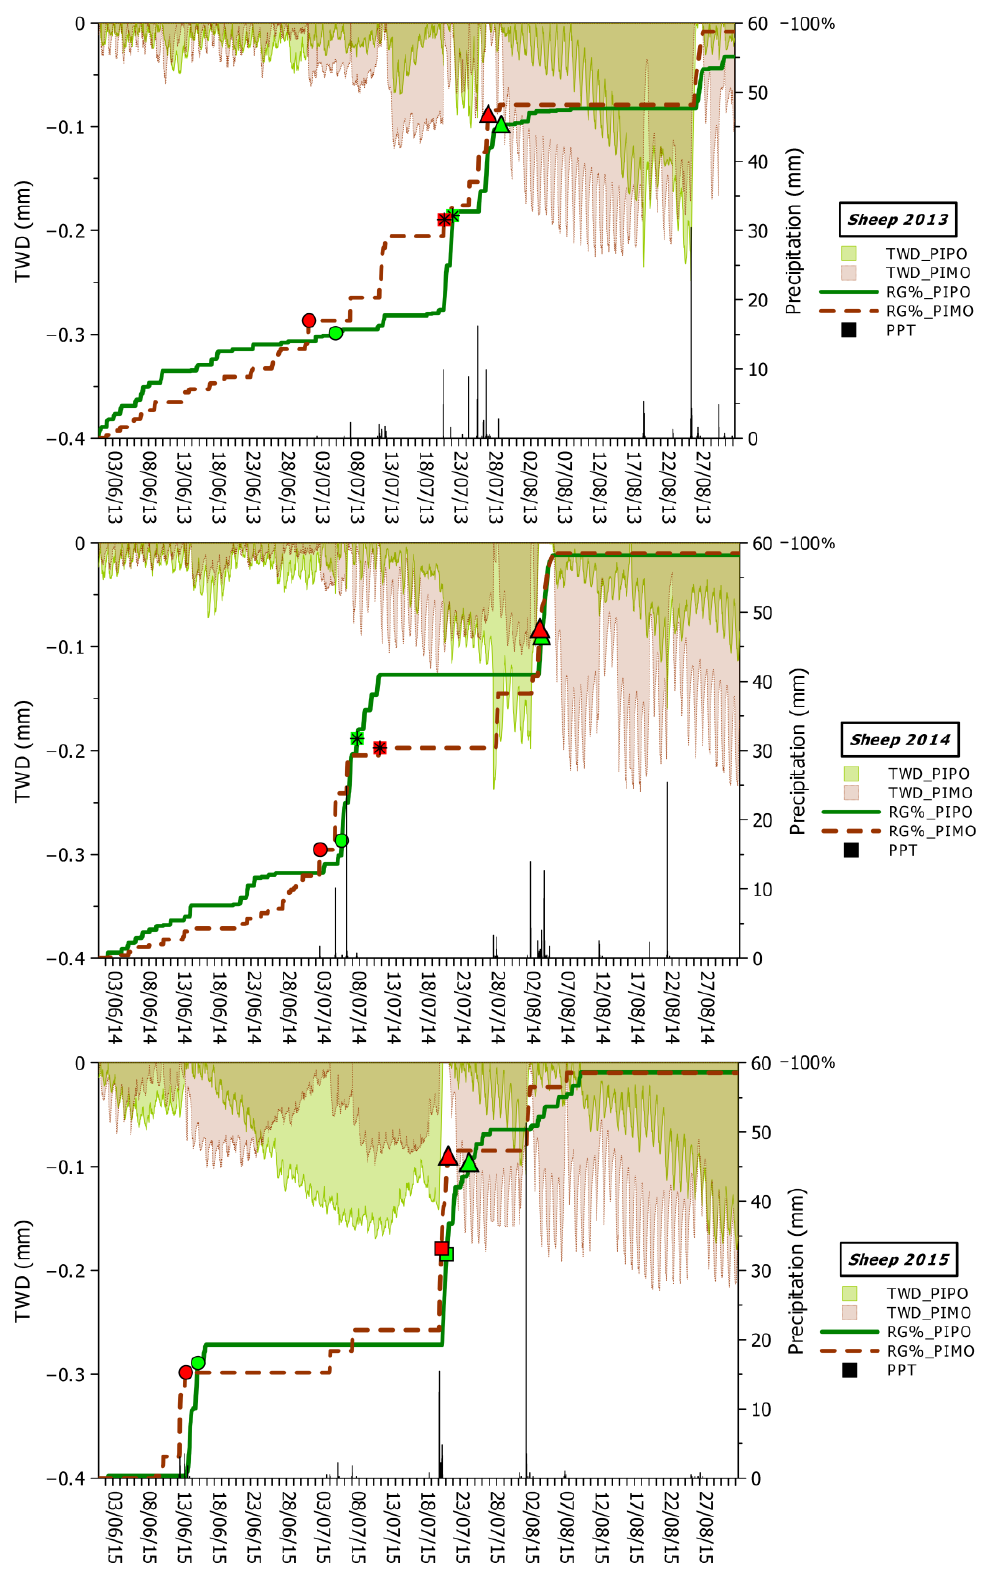
Figure 6. Tree water deficit (TWD) and real growth (RG) time series in 2013–2015 for PIPO and PIMO (Sheep Range). Symbols represent quartiles of real growth observed between June and September (circles = 25%; squares = 50%; triangles = 75%). Vertical bars represent total hourly precipitation. (Right y axes also represent 100% of RG). For a definition of TWD and RG see main text. Species codes are the same as in the Figure 2 caption.